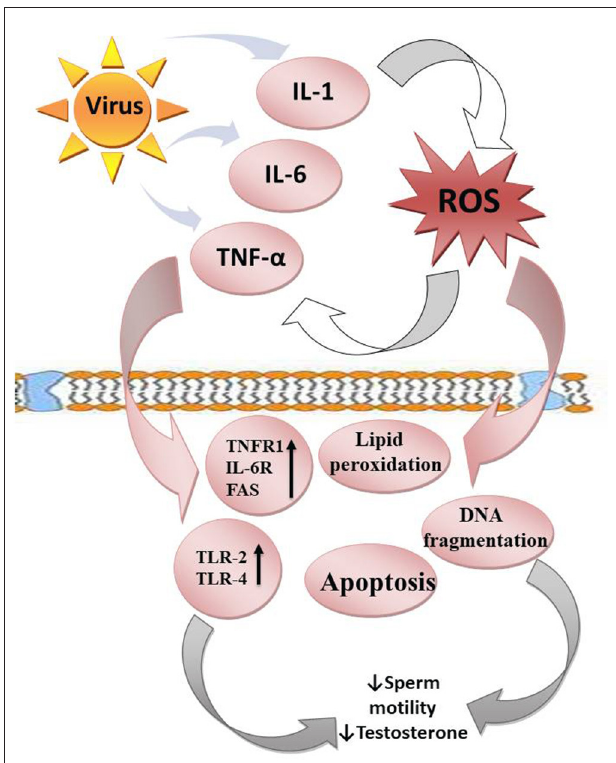
FIGURE 2 | Viruses upregulate the release of proinflammatory cytokines (IL-1, IL-6, and TNF- α ), which enhance ROS release. In response, ROS promote cytokine release. This leads to a vicious cycle. ROS attack the polyunsaturated fatty acids of the plasma membrane, resulting in lipid peroxidation. They also trigger DNA fragmentation and apoptosis of the testes and sperm cells. In addition, the cytokines upregulate TNFR1, IL-6R, FAS, TLR-2, and TLR-4, resulting in reduced sperm motility and